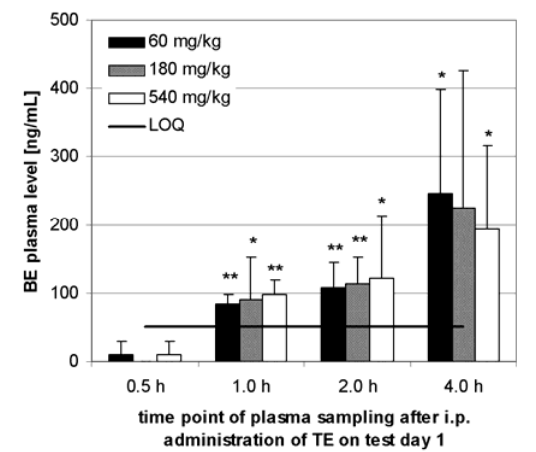
Figure 3 . Plasma BE levels after i.p. administration to 6 Sprague-Dawley rats (3 male, 3 female) in each dose level group. Samples were taken at the specified time after administration on test day 1. Error bars: CI; The increase of BE plasma level in comparison to the level after 0.5 h is shown by t-test.